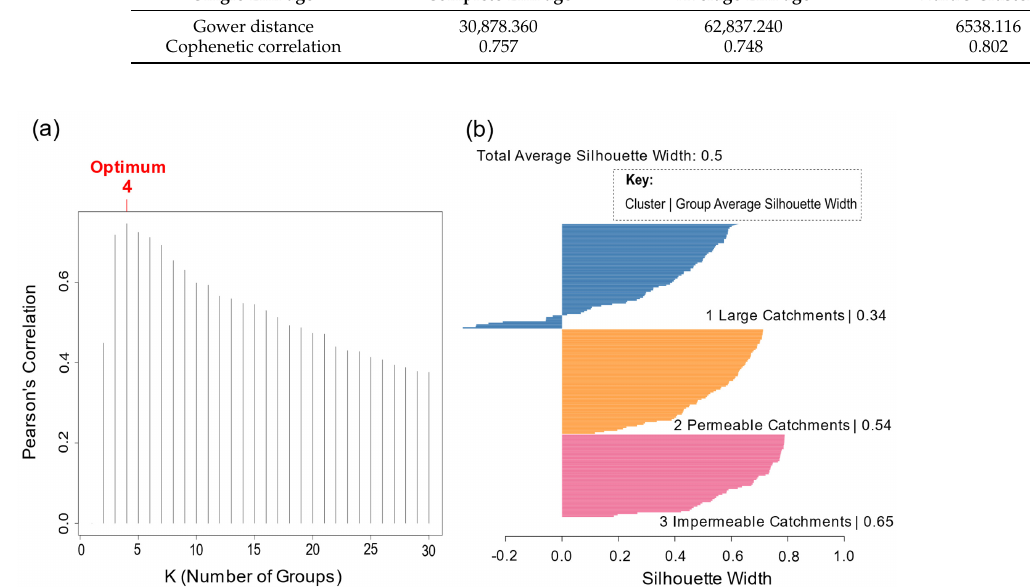
Figure 3. ( a ) The optimum number of average linkage clusters according to the Mantel statistic. The bars show the correlations between original distance matrix and binary matrices computed from the dendrogram cut at various levels. ( b ) Silhouette plot of the final three groups from the average linkage agglomerative clustering.